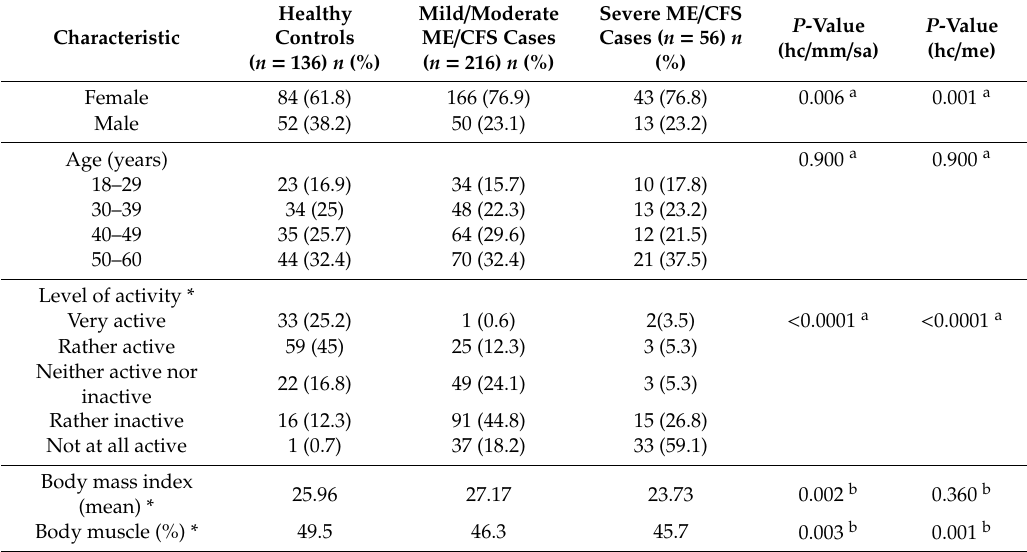
Table 1. Baseline characteristics of study